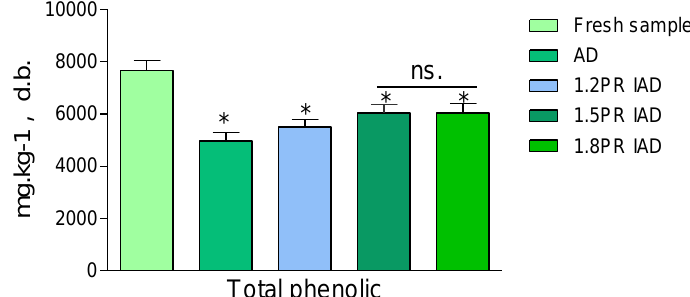
Figure 5. Total phenolic content of litchi dried by drying schemes with di ff erent pulse ratios. Note: AD